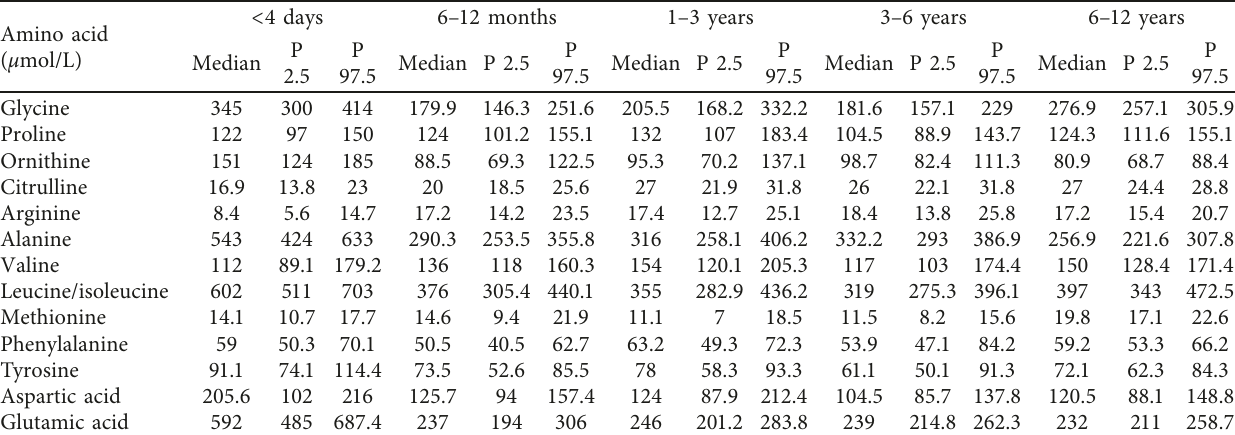
Table 3: Distribution of amino acid concentrations by age groups, displayed as median, 2.5th, and 97.5th